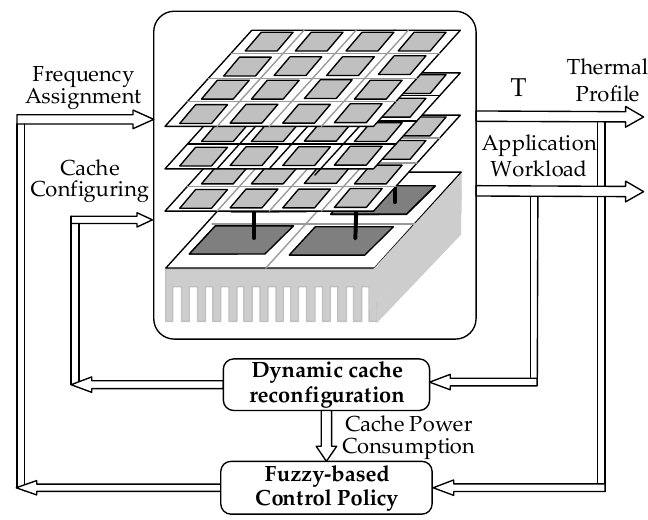
Figure 3. Proposed thermal management scheme.